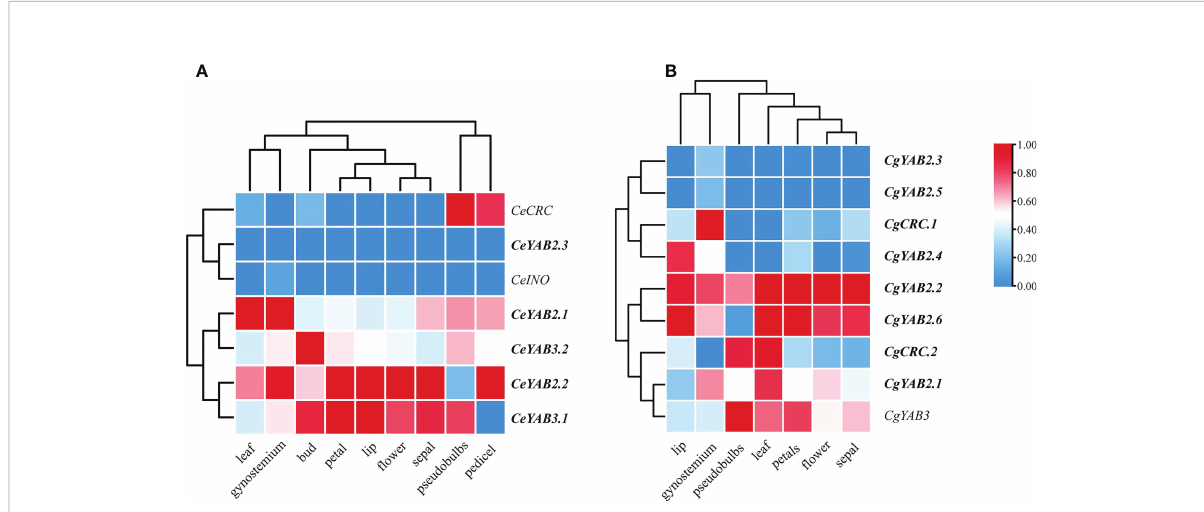
FIGURE 5 Expression patterns of YABBY genes in different organs from three Cymbidium species. (A, B) show the expression patterns of YABBY genes in different organs in C. ensifolium and C. goeringii . The heatmap was produced in Tbtools (Chen et al., 2018). The fragments per kilobase of transcript per million fragments (FPKM) values can be found in Supplementary Table S5. The duplicated genes are shown in